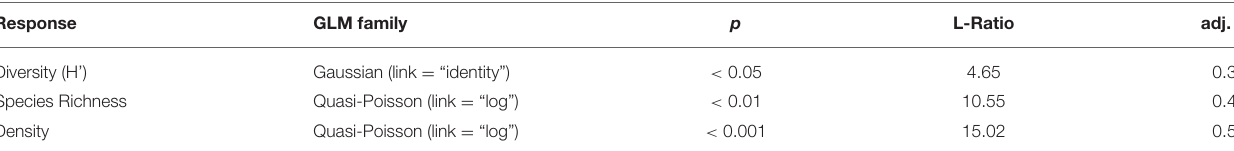
TABLE 4 | Results of generalized linear models for various biotic measures with hydrothermal index (HI).